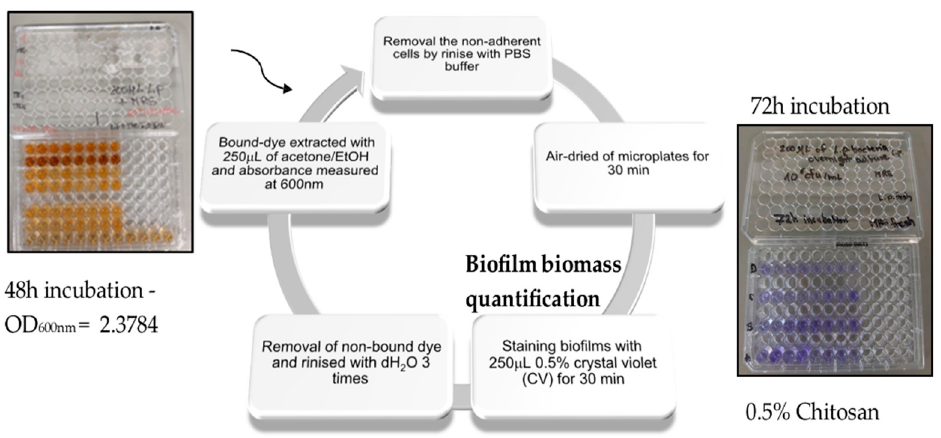
Figure 10. Overview of biofilm inhibition and quantification by crystal violet staining of polystyrene microtiter plates after 24, 48, and 72 h. The data represent the average of three biological replicates of the biofilm formation CV assay.